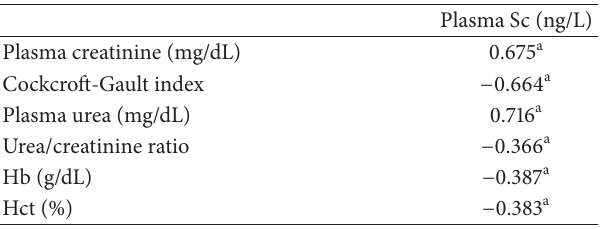
Table 4: Significant correlation coefficients between the study variables and plasma levels of scandium.